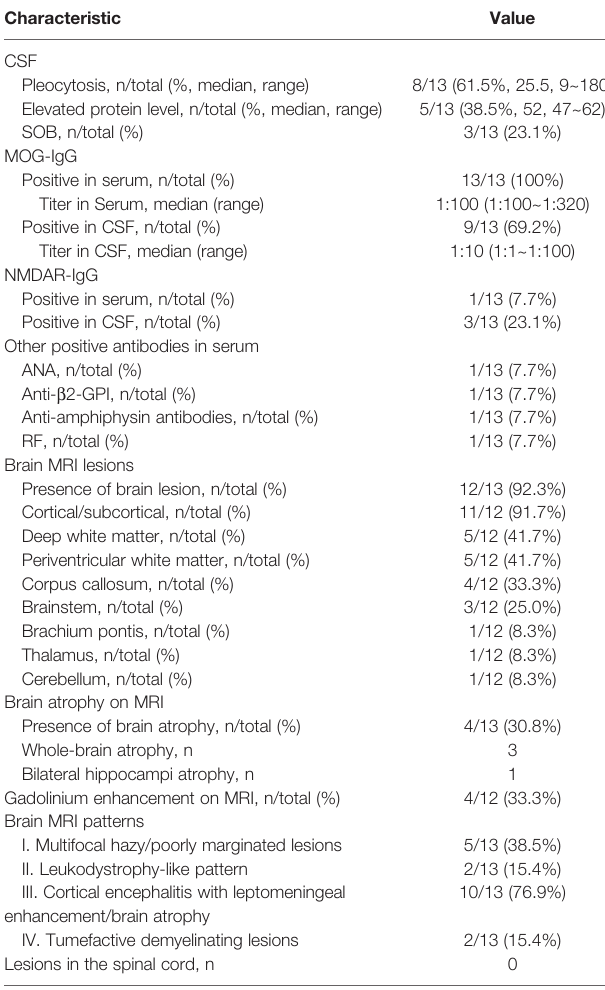
TABLE 2 | Laboratory and radiological fi ndings in 13 patients with MOG-E. Characteristic Value